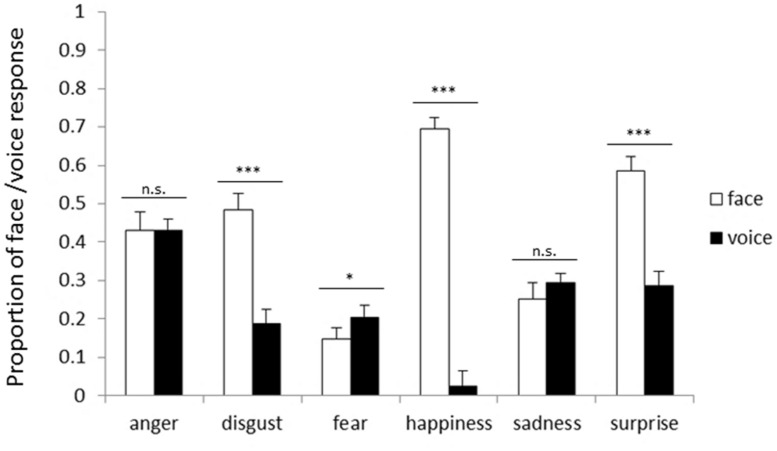
Proportion of facial and vocal response on incongruent trials for each emotion category in the no instruction (NI) block. Error bars represent SE. Asterisks indicate significant differences between modalities (*p < 0.05, ***p < 0.001).